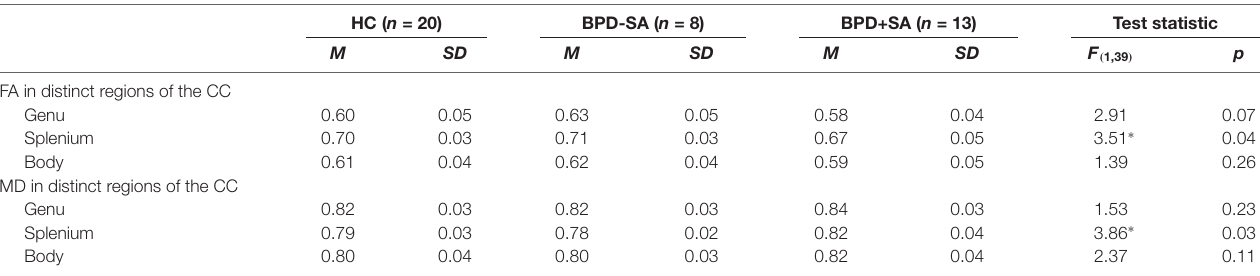
TABLE 2 | Differences in diffusion measures between HC and BPD participants with or without suicidal